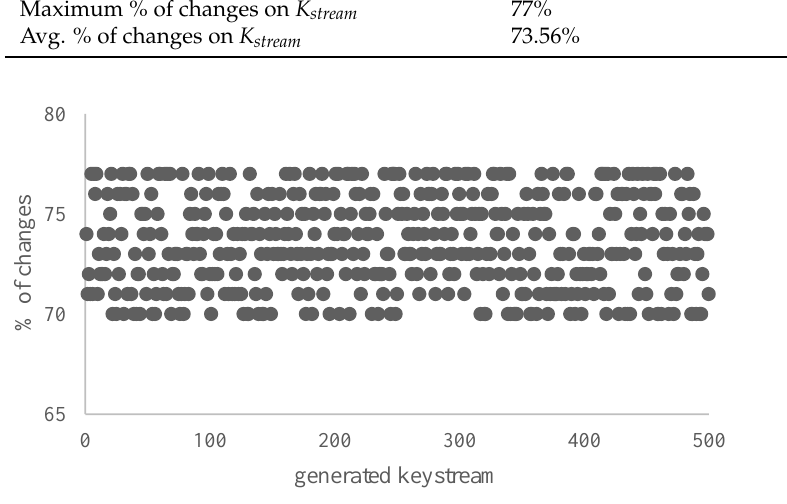
Figure 8. Avalanche effect on K stream .